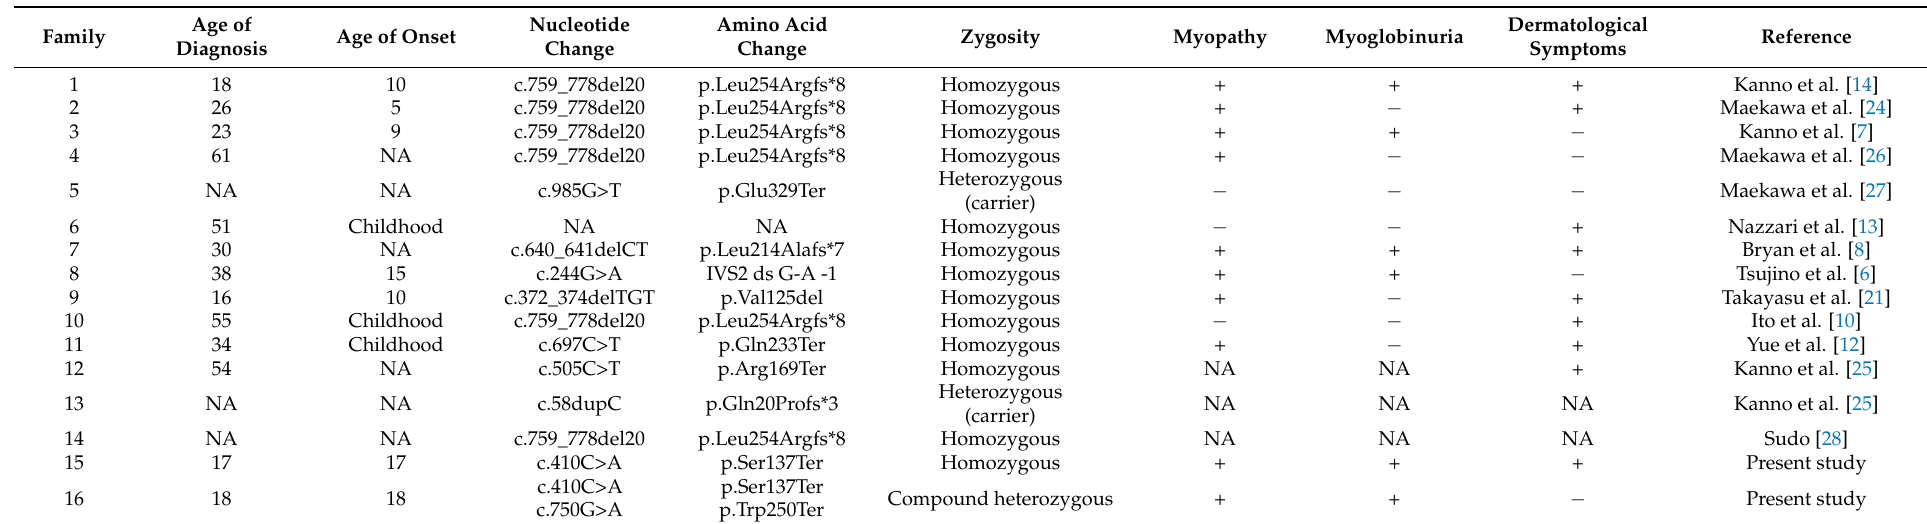
Table 2. Lactate dehydrogenase A gene ( LDHA ) mutations and clinical